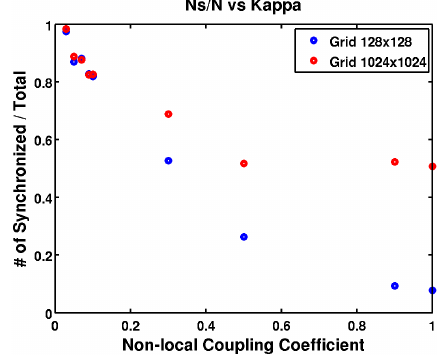
Figure 8. Chimera index as a function of time steps for the 128 × 128 grid without recurrences for κ = 0.10.